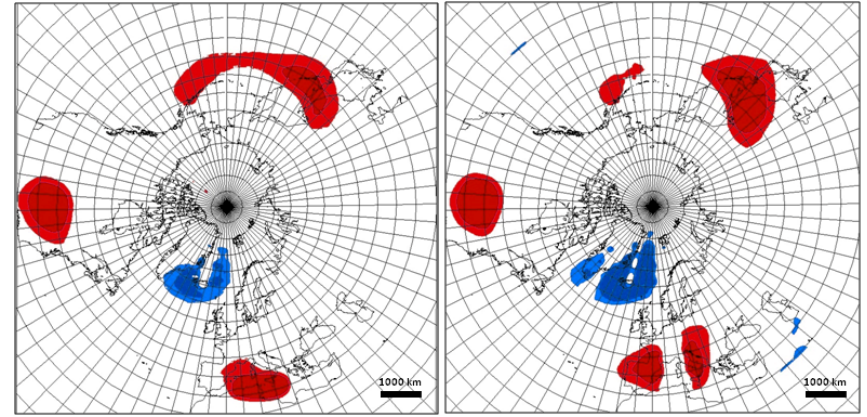
Figure 2. Pearson correlation between solar activity and 500hPa GPH: direct (left) and 1 month lagged (right). White means no significant correlation, light red (blue) stands for significant positive (negative) correlations at 10%; dark red (blue) shows regions of positive (negative) correlation (5% significance).